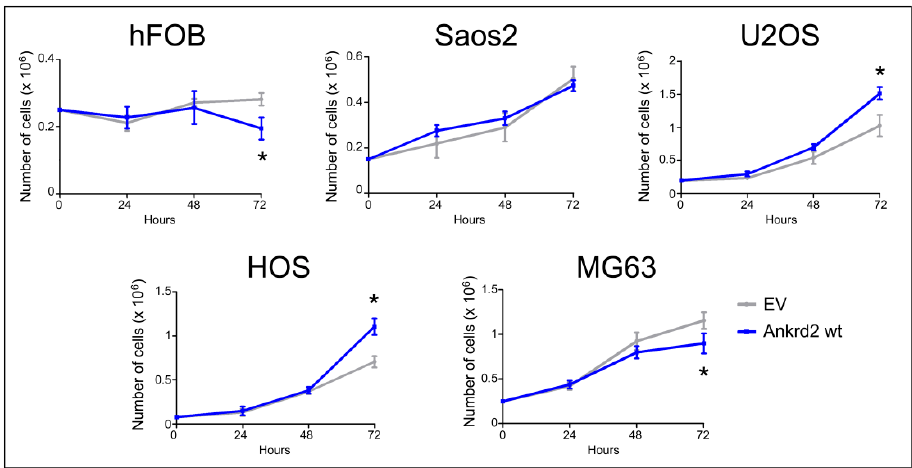
Figure 3. Ankrd2 overexpression affects proliferation of cell lines from OS and normal osteoblasts. Stable clones of hFOB, Saos2, U2OS, HOS and MG63 overexpressing Flag-Ankrd2wt or transfected with empty vector (EV) were seeded as indicated in six-well tissue culture plates. After 24, 48 and 72 h from seeding, cells were individually collected by trypsinization, stained with trypan blue and living cells counted under light microscopy using a hemocytometer. * p < 0.05, vs. control (EV). Data are representative of a minimum of five independent experiments. Data were analyzed and graphed using the GraphPad Prism software.